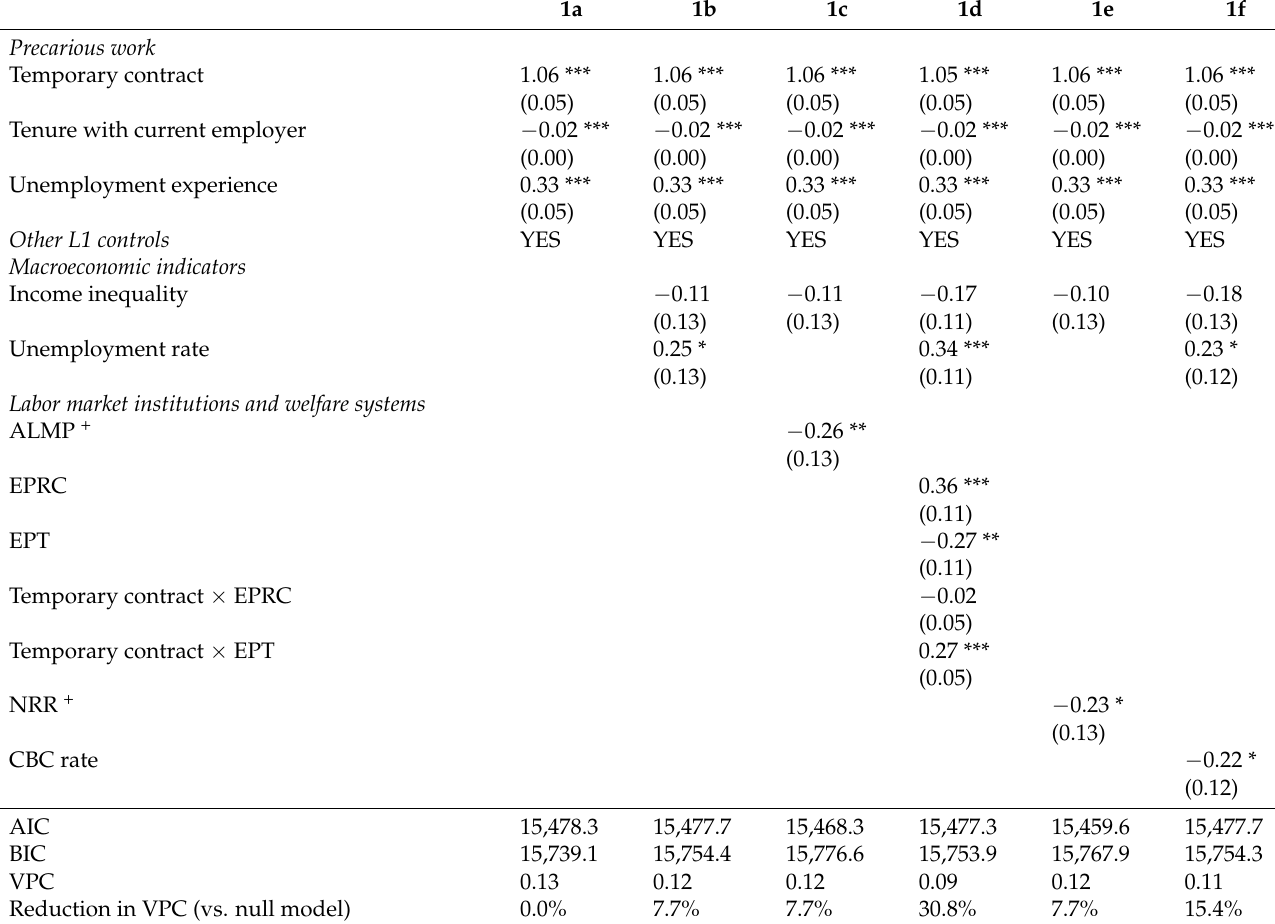
Table 1. Impact of labor market policies and welfare systems on job